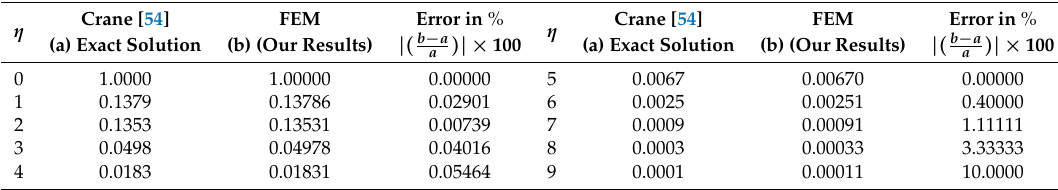
Table 2. Comparison of the exact solution of Crane [54] and FEM for the flow velocity f (cid:48) ( η )